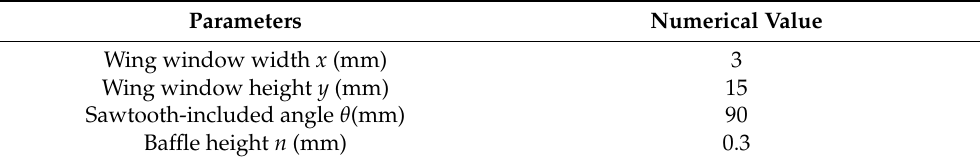
Figure 6. Structure diagram of the serrated fin window . Table 3. Structural parameters of the serrated fin